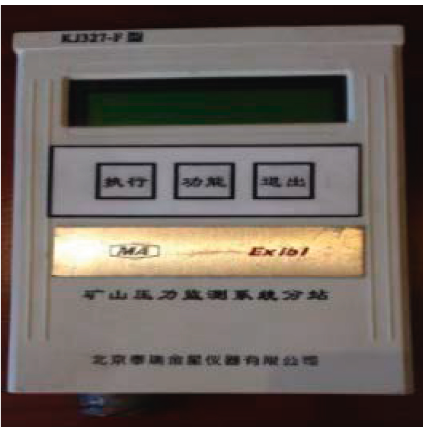
Figure 4: KJ 327-F portable digital static-resistance strain